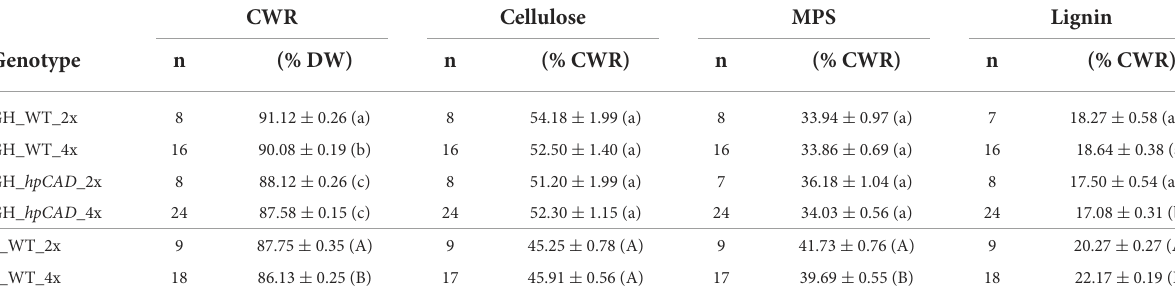
TABLE 1 Cell wall composition of di- and tetraploid poplar trees.